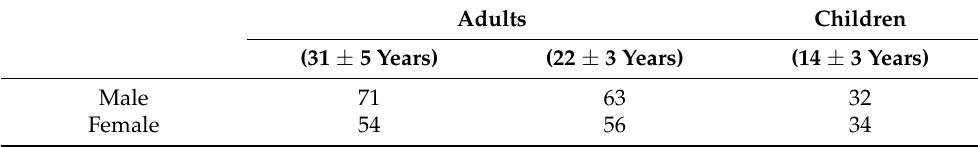
Table 1. Patients and healthy controls included in the study grouped by gender and